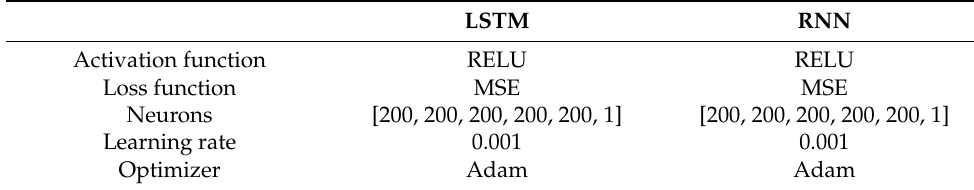
Figure 5. The layers of the RNN model. Table 1. Hyperparameter of each